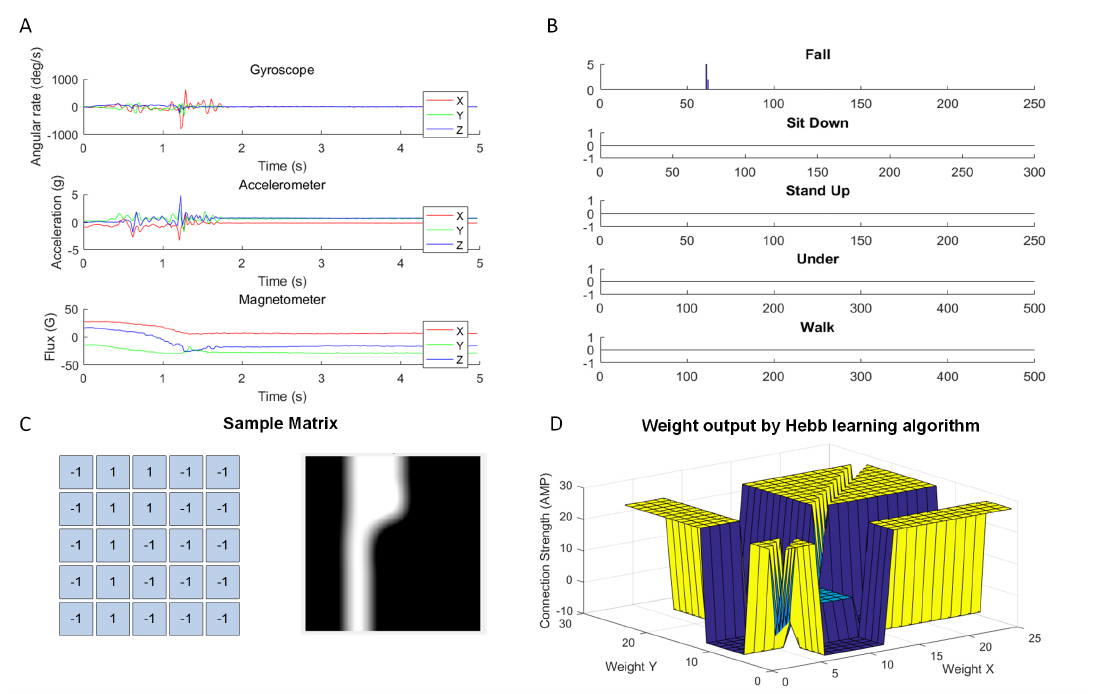
Figure 7. The Sensor data converted into Hopfield neural network of sample and weight, ( A ) Raw IMU sensor signal output, ( B ) Sensor data feature extraction and binary conversion, ( C ) Fall activity sample matrix of feature map, ( D ) Hebb learning algorithm output the Hopfield neural network